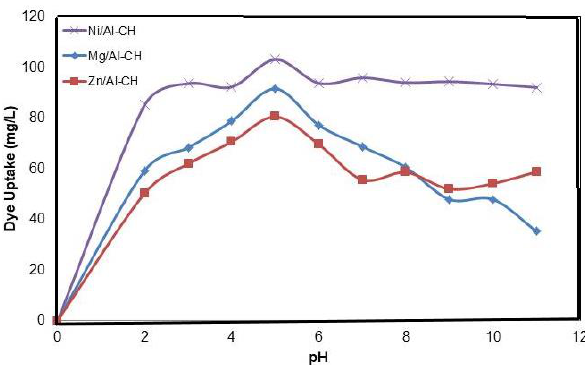
Figure 5. pH optimum of CR using Zn/Al-CH, Mg/Al-CH, and